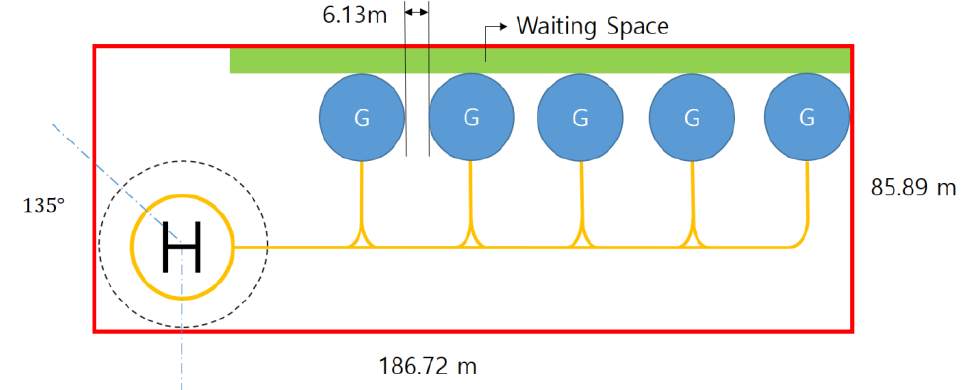
Figure 13. Example of pier topology that complies with the FAA’s new regulations.